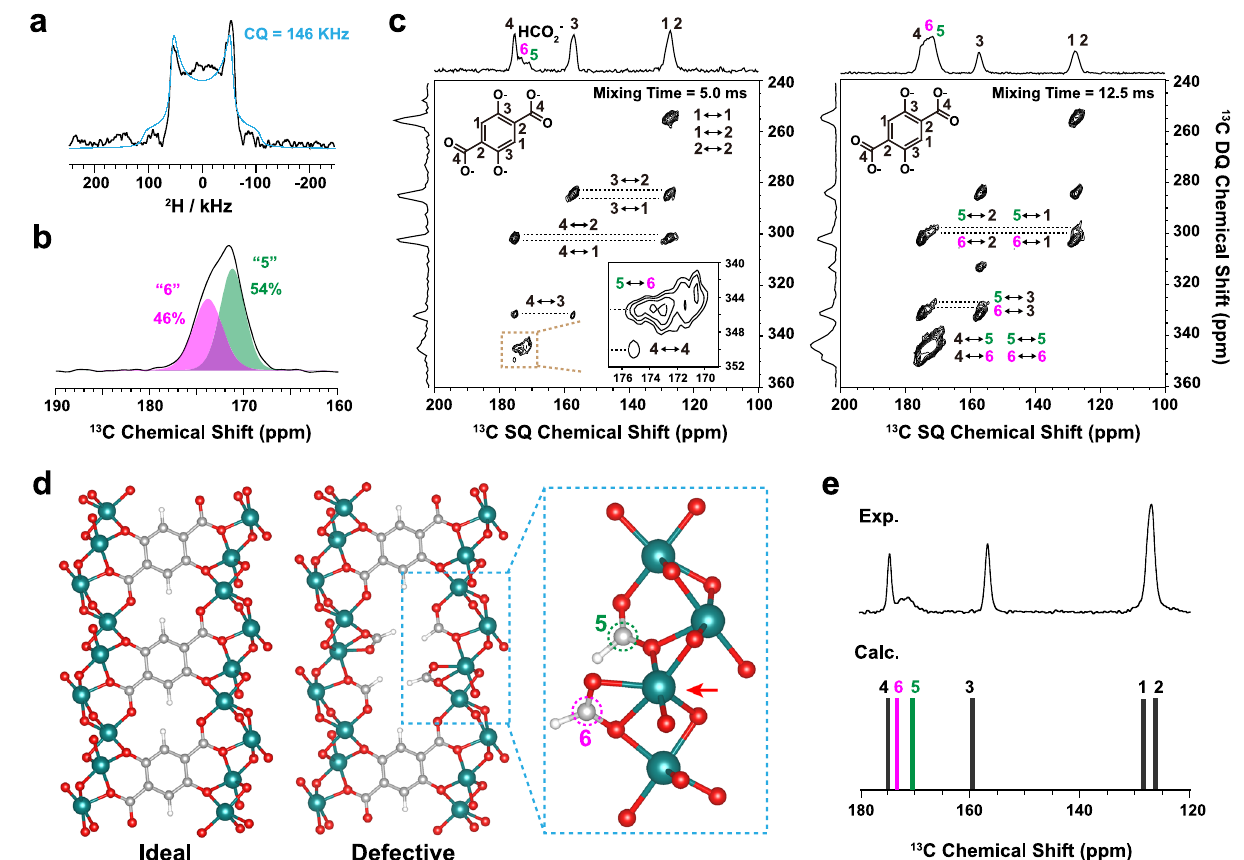
Fig. 2 | The determination of formate coordination structure. a Experimental (black)and fi tted (blue) 2 Hquadrupolarpatternsofthed 1 -formateindefectiveMg- MOF-74. The NMR experiment was performed at 300K. The quadrupolar splitting (C Q ) of 2 H pattern is ~146kHz. b The 13 C CPMAS spectrum of coordinated formate (CT=50 μ s) in defective Mg-MOF-74.The formate signalcanbe deconvoluted into two sites labeled as “ 5 ” and “ 6 ” . c 2D 13 C- 13 C double-quantum single-quantum